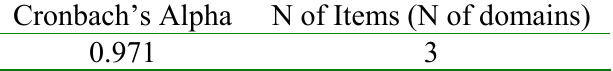
Reliability Statistic for the Writing Test ( N